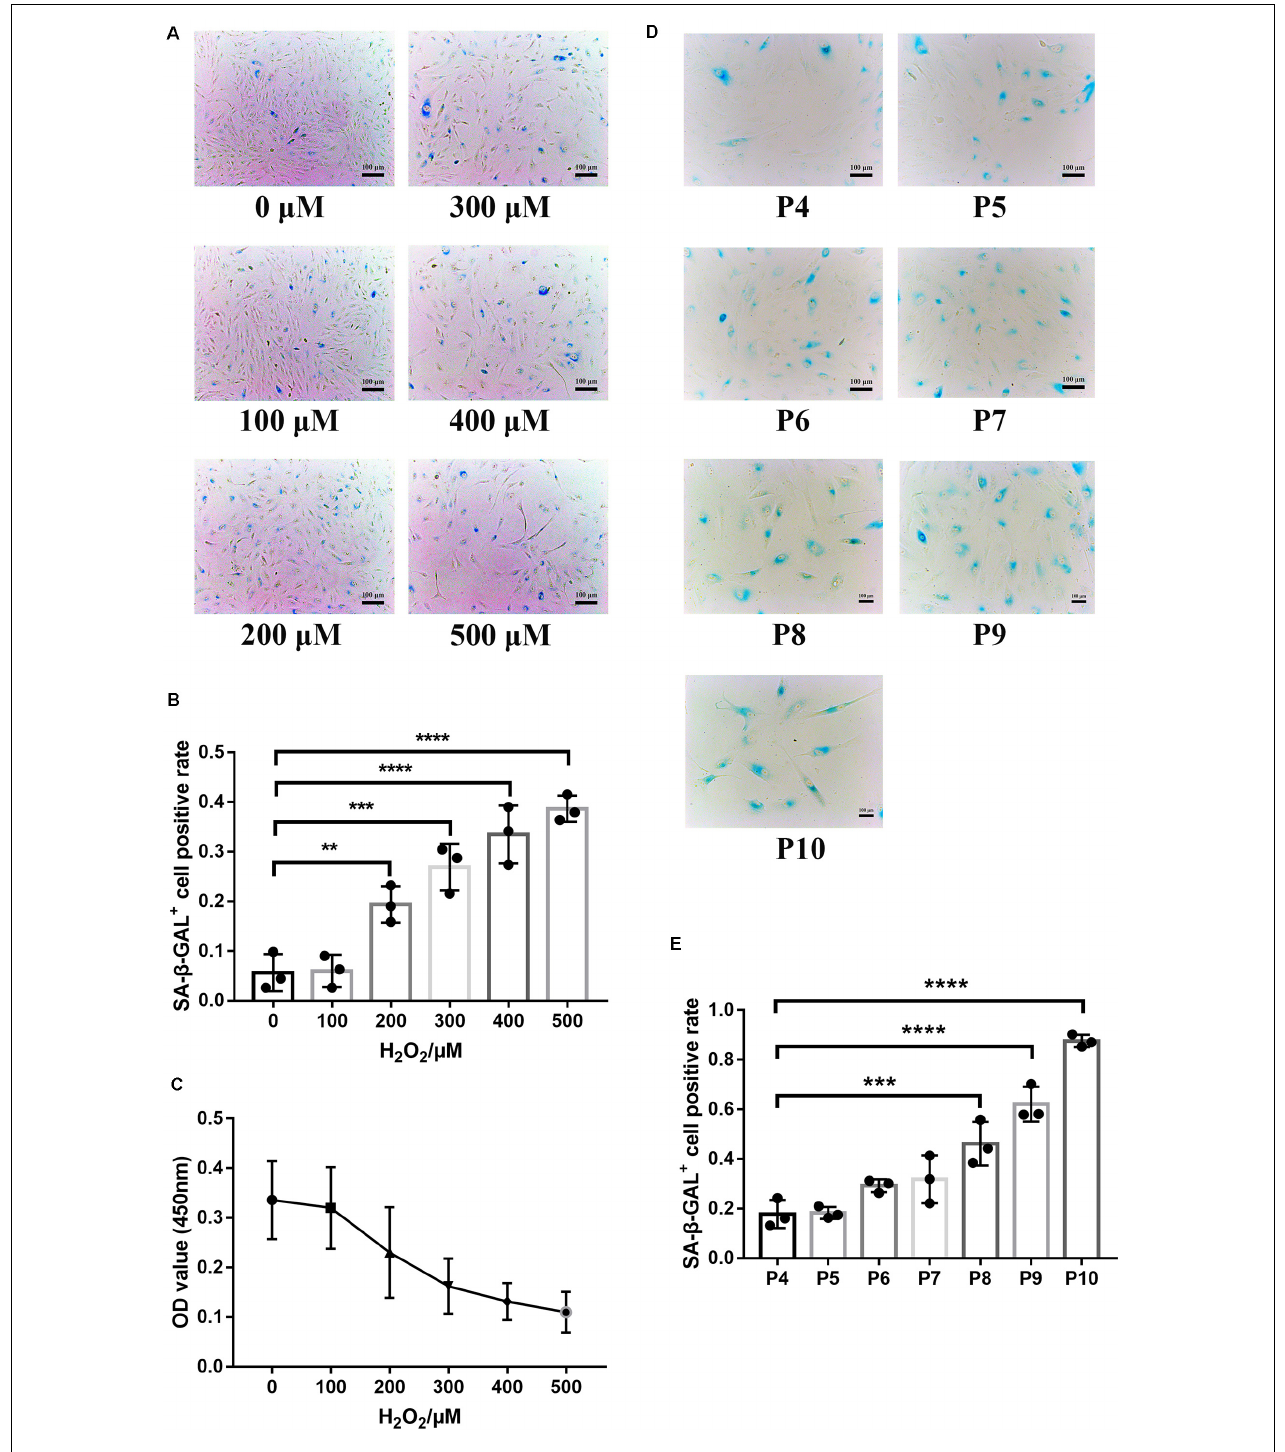
FIGURE 2 | Establishment of RPE premature and replicative senescence cellular models. (A) Senescence-associated galactosidase (SA- β -GAL) activity in RPE cells treated with different concentrations of hydrogen peroxide (H 2 O 2 ), as indicated by phase contrast microscopy. Scale bar, 100 µ m. (B) Results from the quantification of SA- β -GAL + cells shown in (A) . SA- β -GAL + cells in 4 random fields were scored ( n = 3 biological repeats). The results are expressed as the percentage of stained cells. (C) Proliferation of RPE cells treated with different concentrations of H 2 O 2 , as assessed by a Cell Counting Kit 8 (CCK-8) proliferation assay ( n = 6 biological repeats). (D) SA- β -GAL activity in RPE cells from passages 4 to 10, as indicated by phase contrast microscopy. Scale bar, 100 µ m. (E) Results from the quantification of SA- β -GAL + cells shown in D. SA- β -GAL + cells in 3 random fields were scored ( n = 3 biological repeats). The results are expressed as the percentage of stained cells. Data are presented as the mean ± SD. ∗∗ P < 0.01; ∗∗∗ P < 0.001; ∗∗∗∗ P < 0.0001.